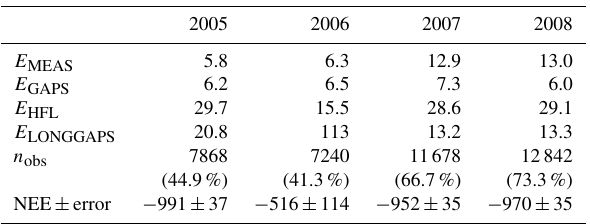
Table B1. Uncertainty analysis of the annual CO 2 balance, NEE (gCO 2 m − 2 a − 1 ) . Error components are explained in the text, and n obs denotes the number of accepted flux observations in 2005–